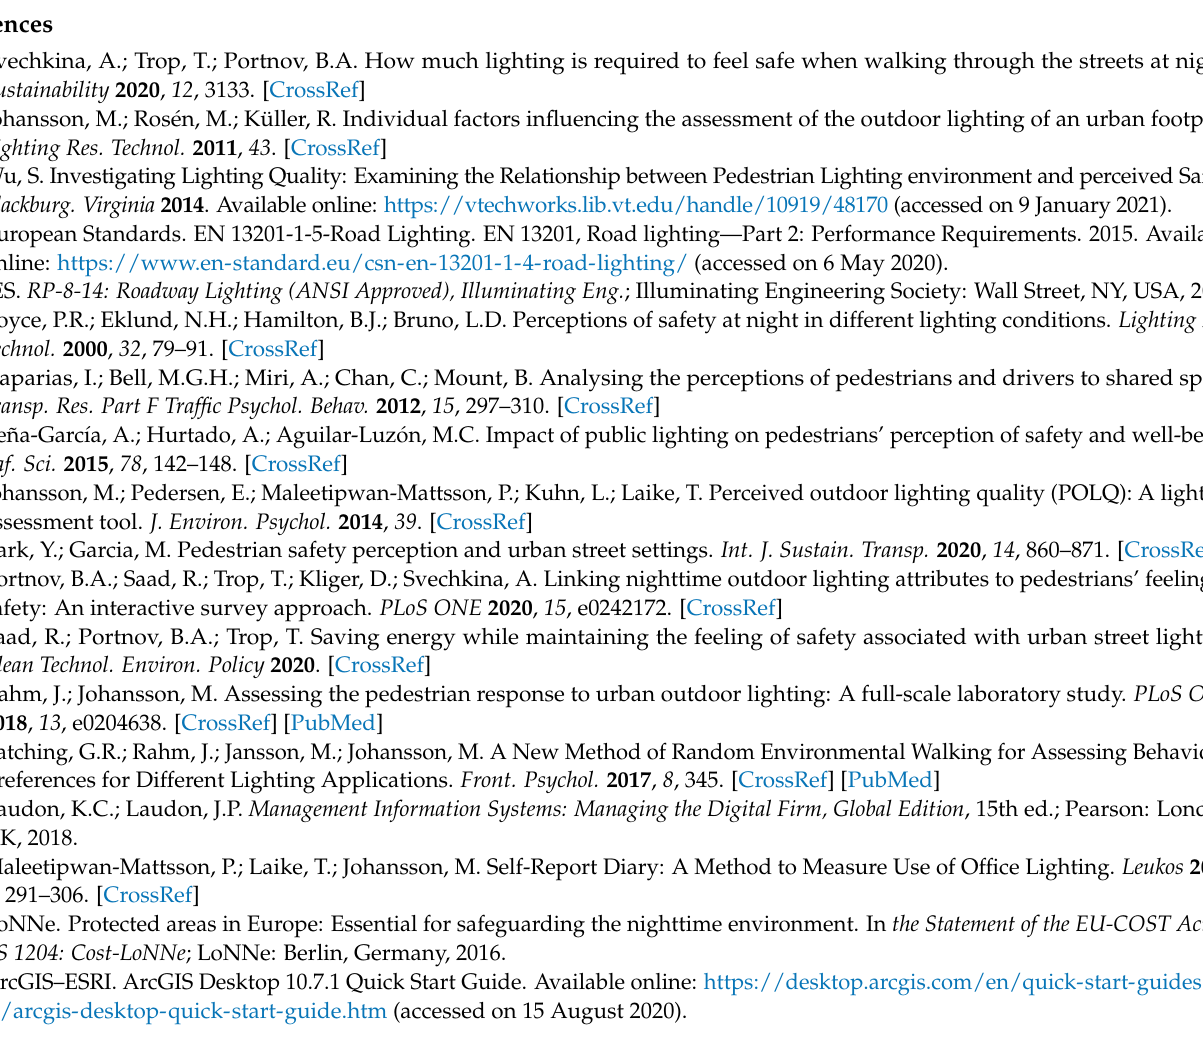
Figure A2. Scatterplots showing the relationships between illumination indices—( A ) CRI vs. CCT; and ( B ) CRI vs.